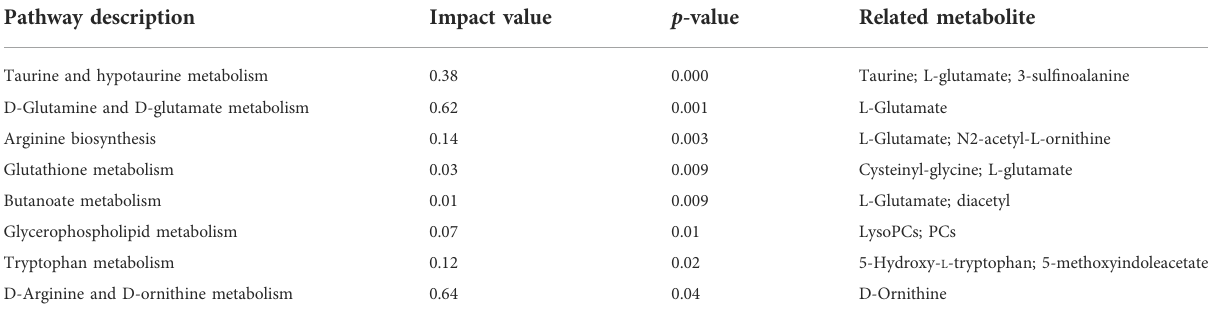
TABLE 1 Metabolic pathways associated with AGE